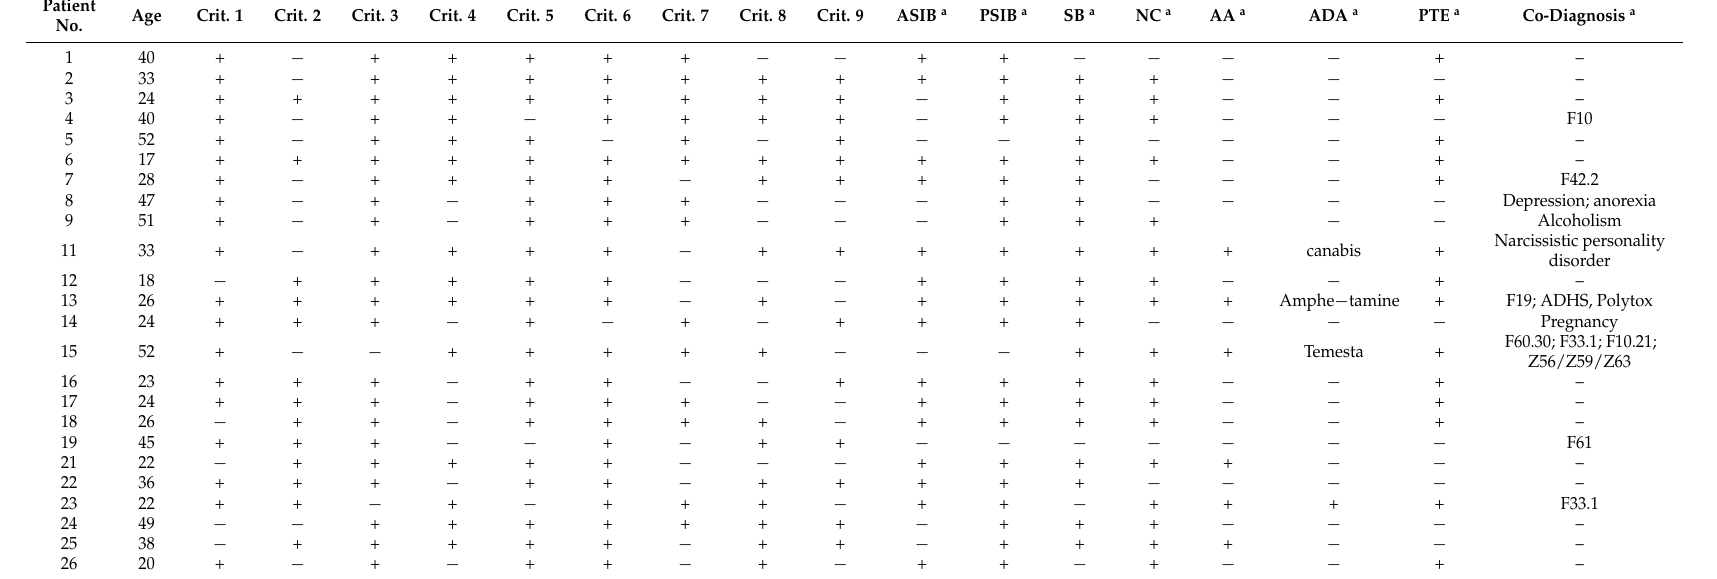
Table 2. Clincopathological parameters of borderline personality disorder (BPD)